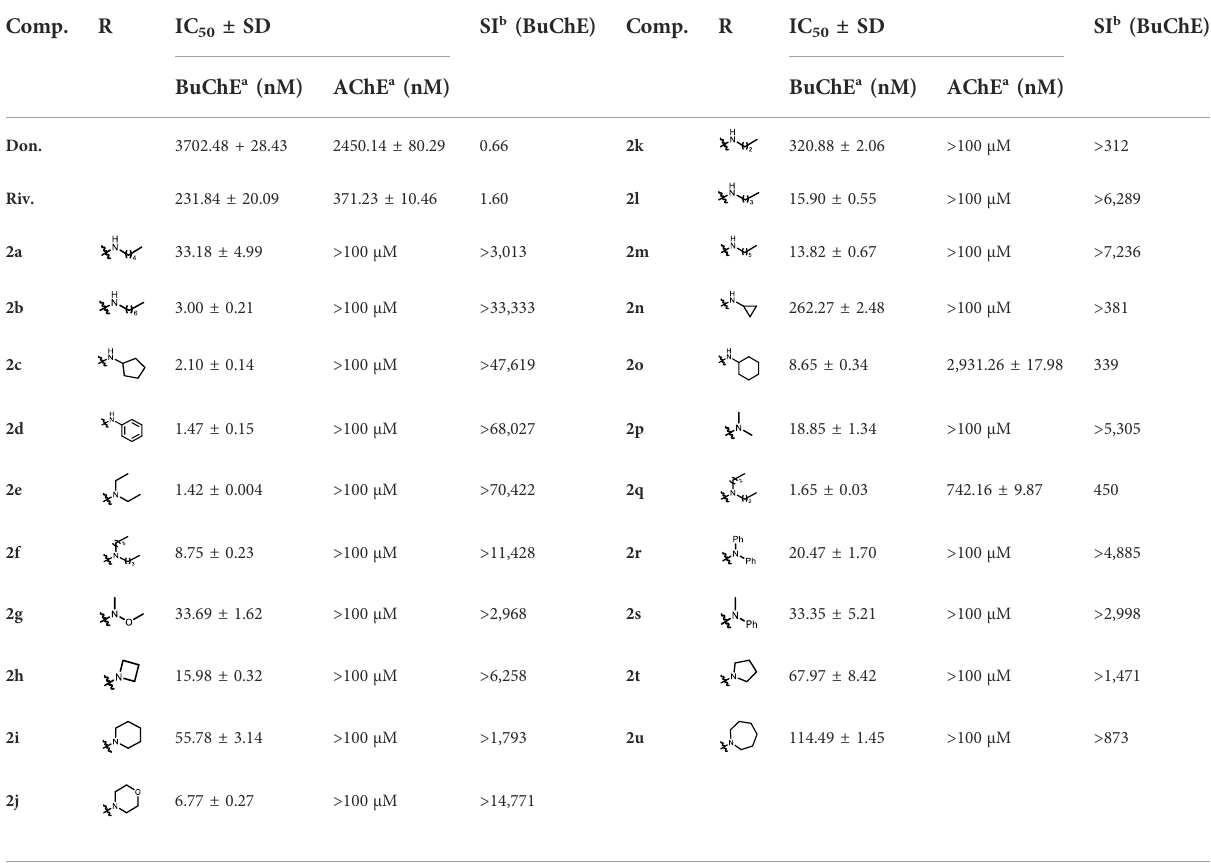
TABLE 1 AChE and BuChE inhibitory activity (IC 50 ) of compounds 2a-2u. Comp.